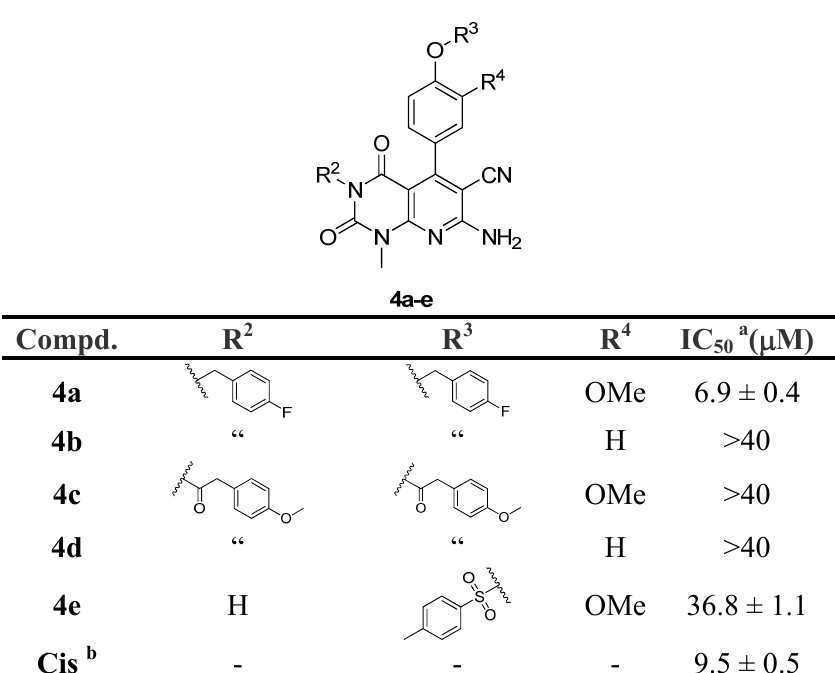
Table 3. IC values of compounds 4a–e on SW620 50